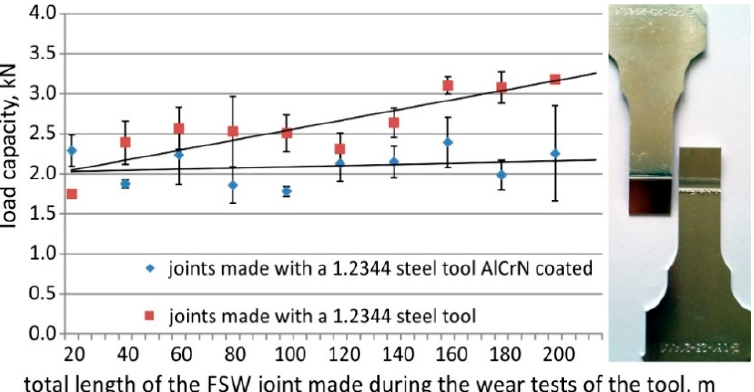
Figure 10. Strength of FSW test joints welded during wear tests of steel tools without a coating and with the AlCrN protective coating.